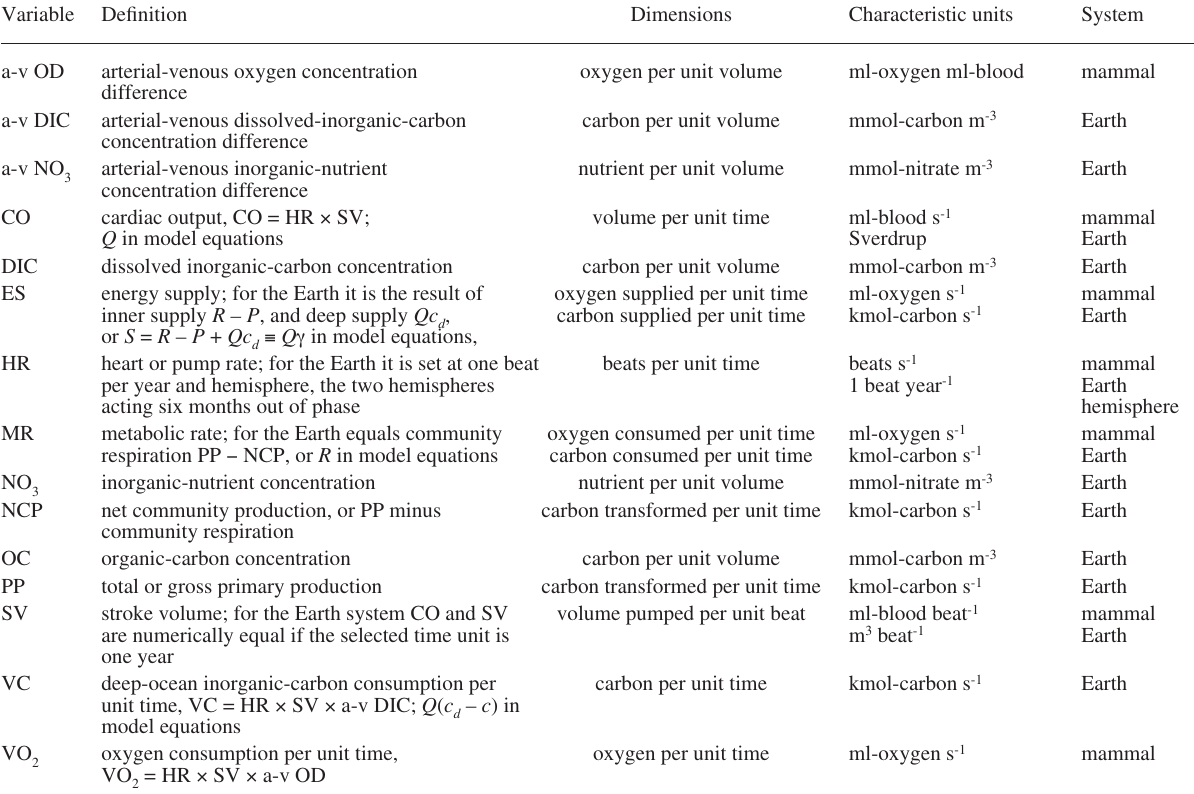
Table 1. – abbreviations for physiological variables used in the text, together with their definition, dimensions, characteristic units, and the system where they apply. related symbols in the model equations are also included.